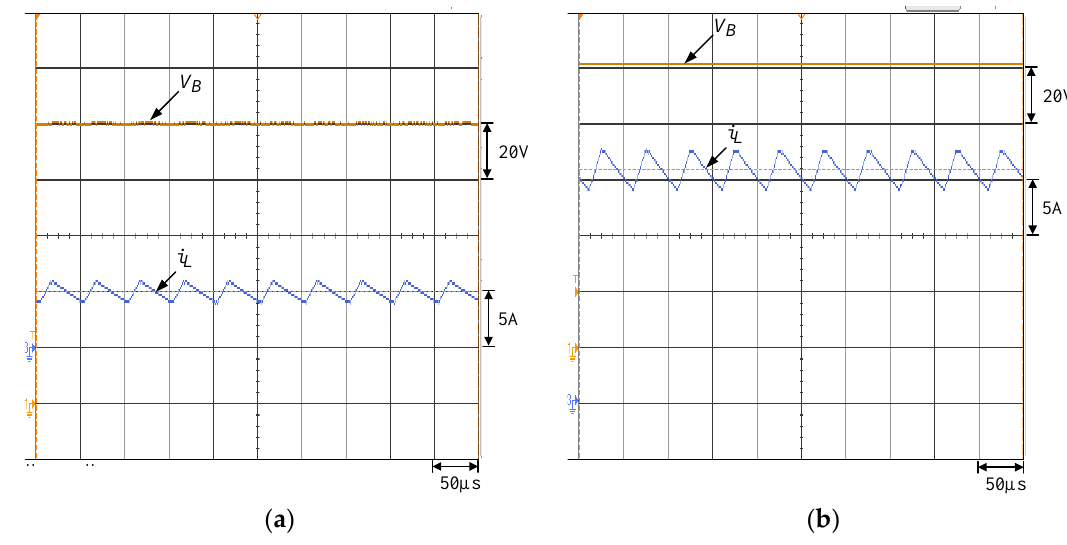
Figure 3. Inductance current and battery voltage at constant load resistance: ( a ) current command 5 A, 20 Ù (500 W); ( b ) current command 20 A, 5 Ù (2 kW).